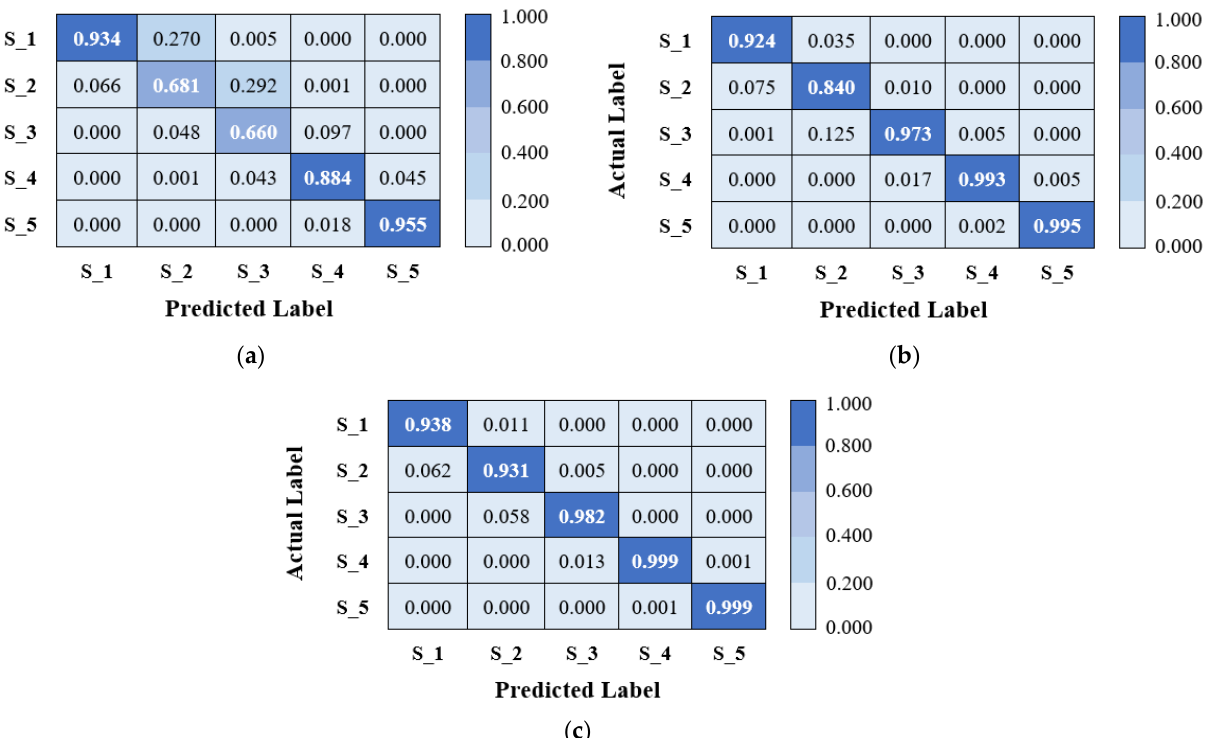
Figure 12. Confusion matrix for 20°/20° tooth pro fi le: ( a ) SNR = 5; ( b ) SNR = 10; ( c ) SNR = 15.